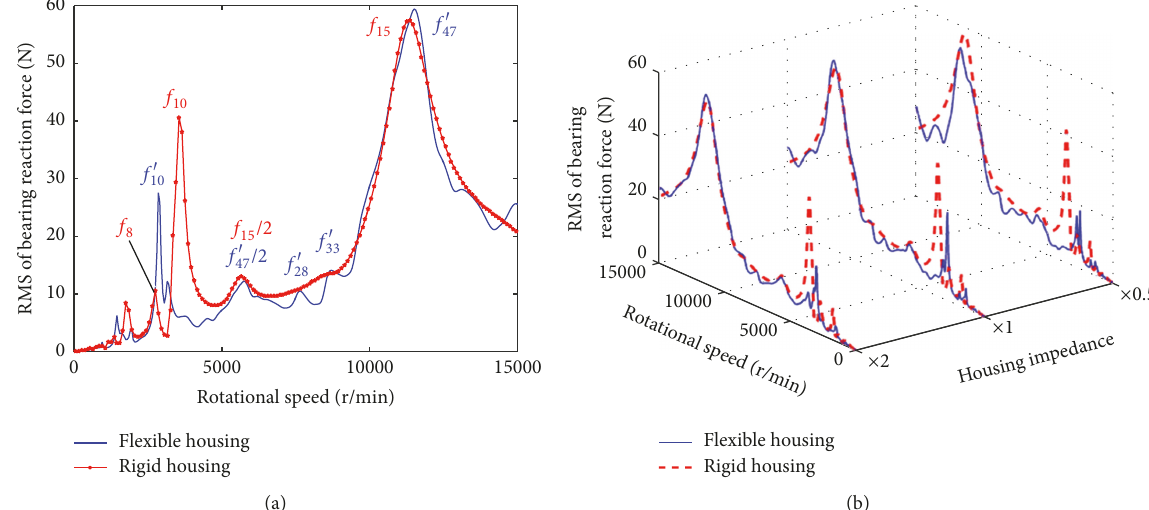
Figure 12: Housing influence on the RMS of dynamic force of the 1st bearing: (a) original housing impedance; (b) modified housing